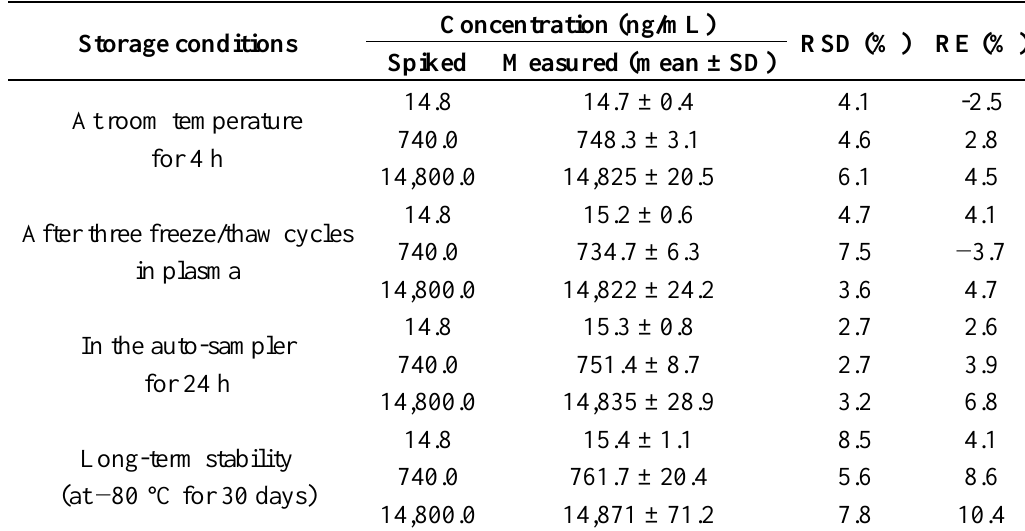
Table 4. Stability of QGR in rat plasma ( n = 6).